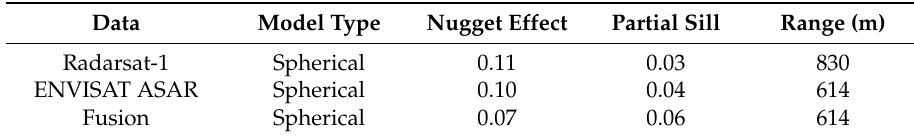
Table 7. Model type and associated parameters for the variogram of residuals.